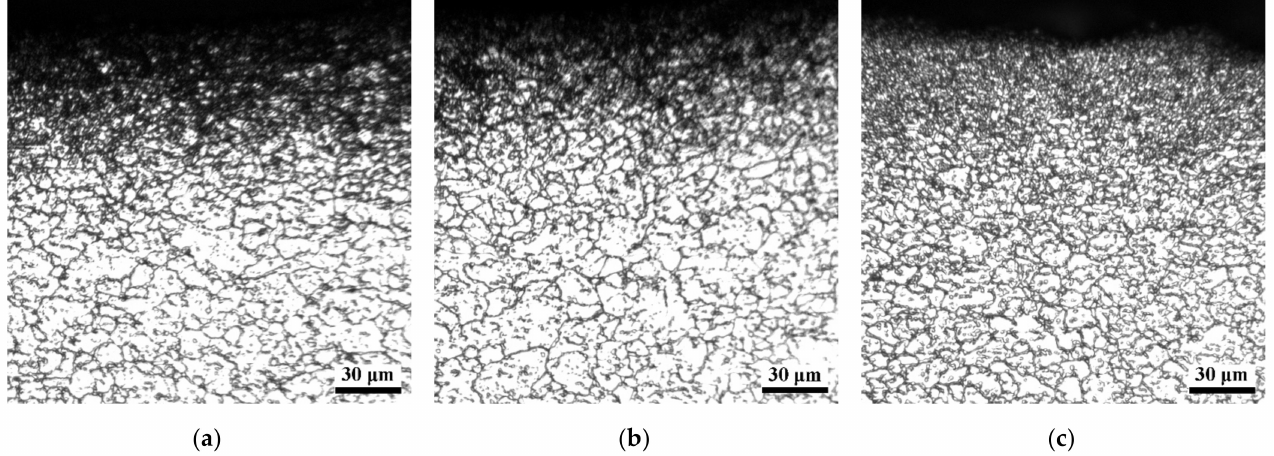
Figure 5. Cross-sectional optical microstructure of the shot-peened and the subsequently annealed specimens with ( a ) 650 ◦ C, ( b ) 750 ◦ C, and ( c ) 850 ◦ C annealing temperatures.